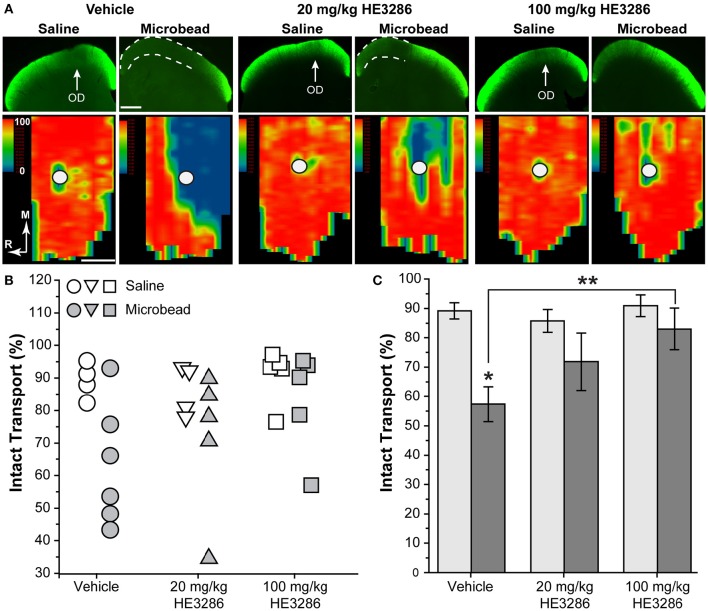
HE3286 treatment rescues axonal transport following microbead occlusion. (A) Coronal sections (top row) through the superior colliculus following intravitreal injection of CTB (green) into saline- and microbead-injected eyes of vehicle- and HE3286-treated rats. Deficits in anterograde transport of CTB (dotted lines) due to microbead-induced elevations in IOP are most apparent in vehicle rats. Representation of the optic disc in the retina (OD) lacks transport due to absence of RGCs. Retinotopic maps (bottom row) reconstructed from serial sections of SC with optic disc indicated (circles). Density of the transported CTB signal ranges from 0% (blue) to 50% (green) to 100% (red). Medial (M) and rostral (R) orientations are indicated. Scale: 500 μm. (B) Intact transport for individual saline- and microbead-injected eyes per treatment group given as fraction of SC retinotopic map with CTB signal ≥70% of the maximum. Two SCs from saline-injected eyes of vehicle-treated rats and one SC from a saline-injected 20 mg/kg HE3286-treated rat were excluded from analysis due to lack of CTB uptake by RGC. (C) Mean level of intact transport in SC was reduced by elevated IOP in vehicle group compared to saline eye (*p = 0.003). Higher dose of HE3286 prevented this reduction (**p = 0.025). n = 4–6 animals per treatment group.